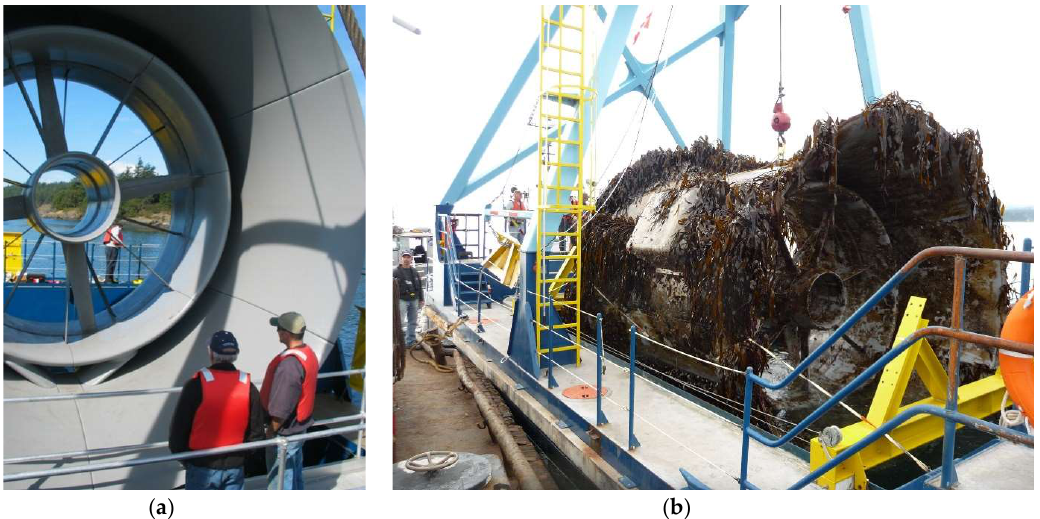
Figure 3. Biofouling attachment on a TST: ( a ) prior deployment, ( b ) TST retrieved from the ocean after some months [15,16].